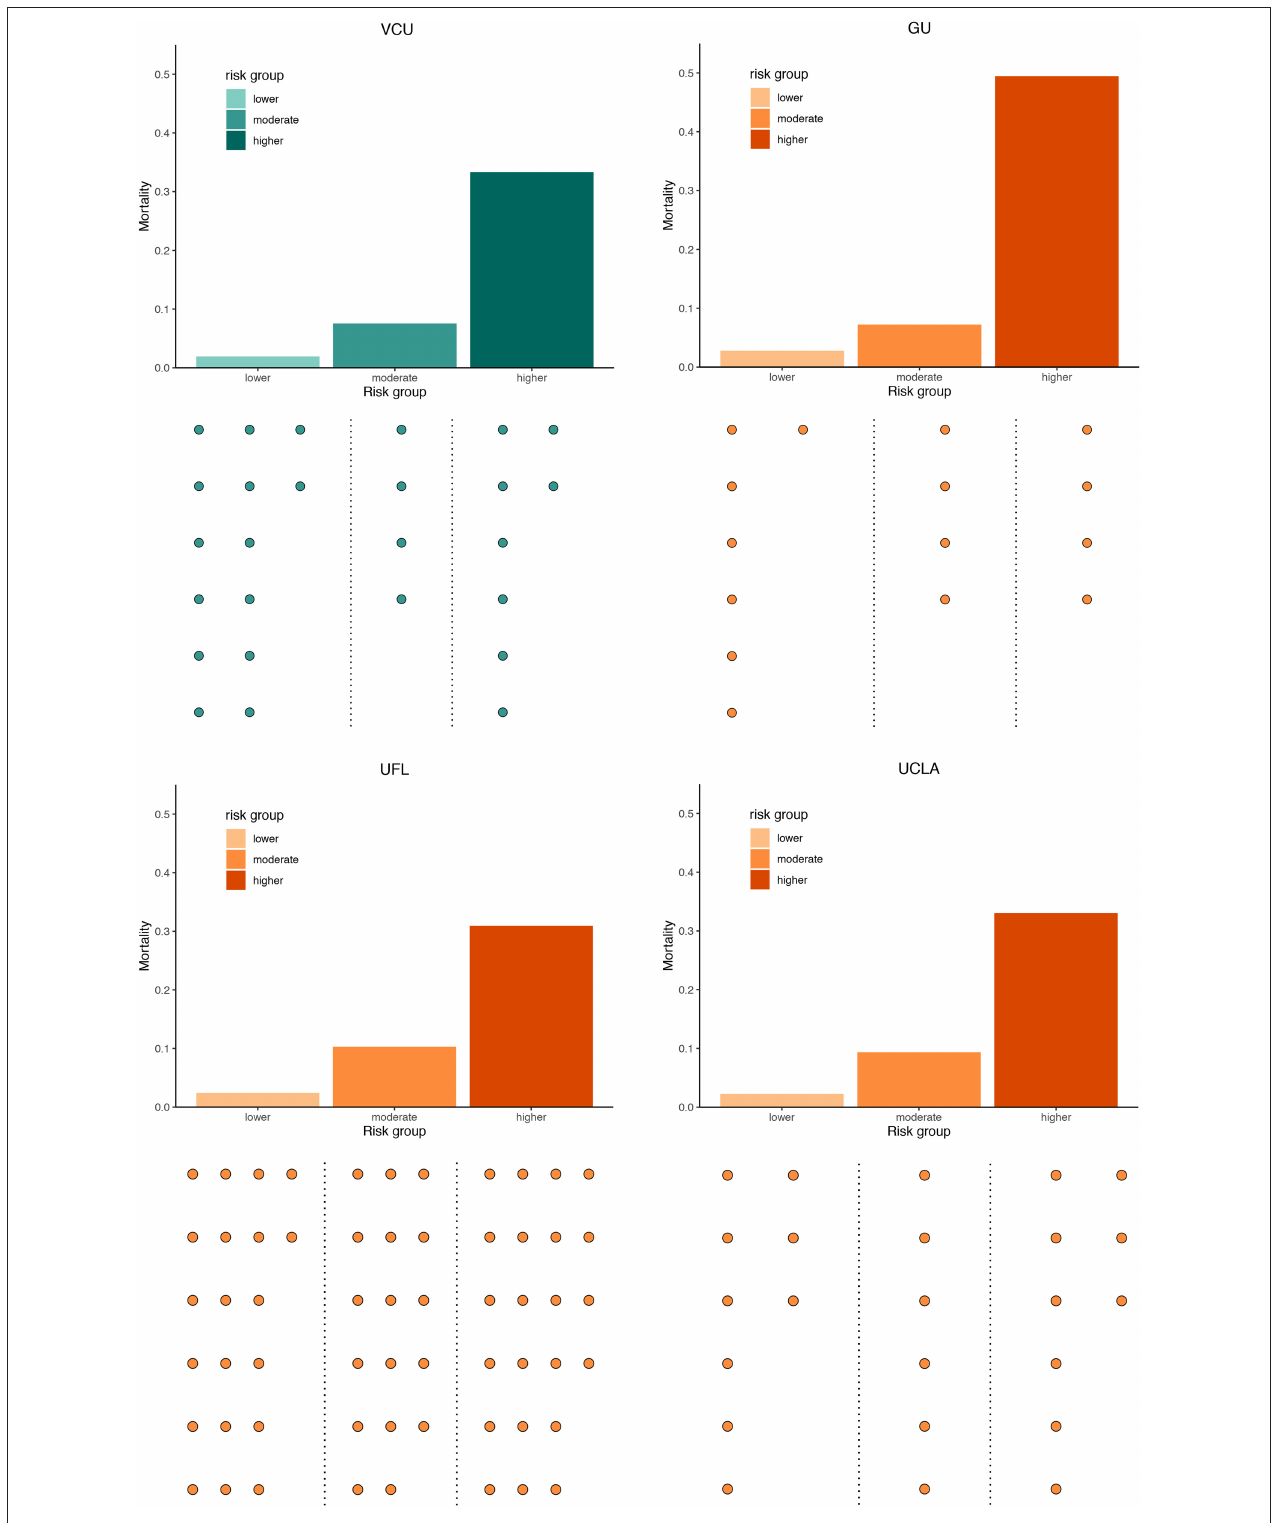
FIGURE 2 | Risk Stratification Among Derivation and Validation Cohorts. Bar plots represented mortality risk. A dot below each main plot represented five people within each corresponding group, and the number of dots suggests the approximate sample size in each group.